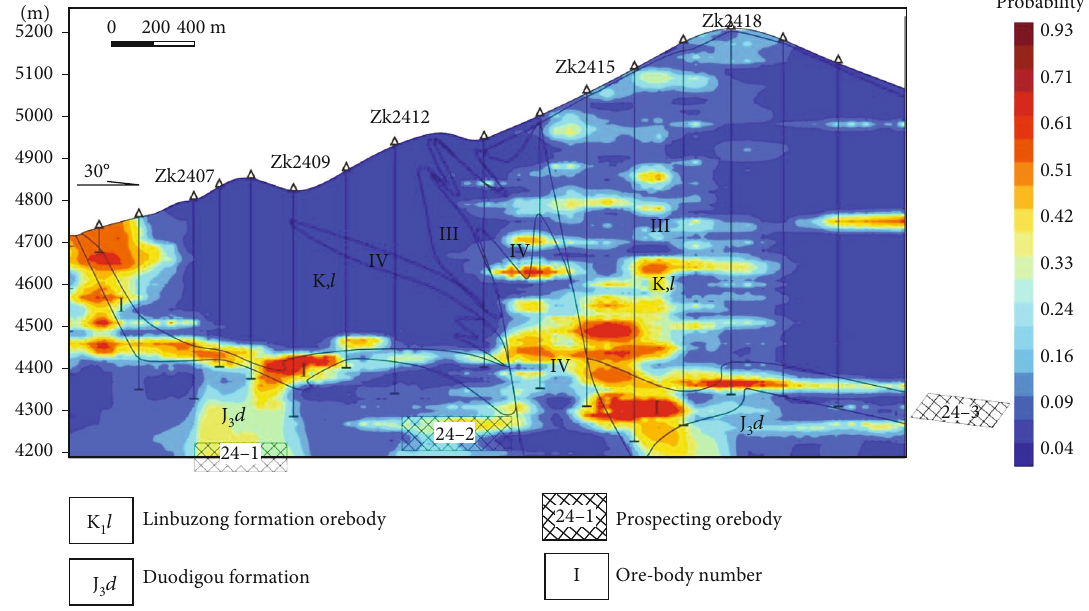
Figure 8: Predicted exploration targets for the #24 pro fi